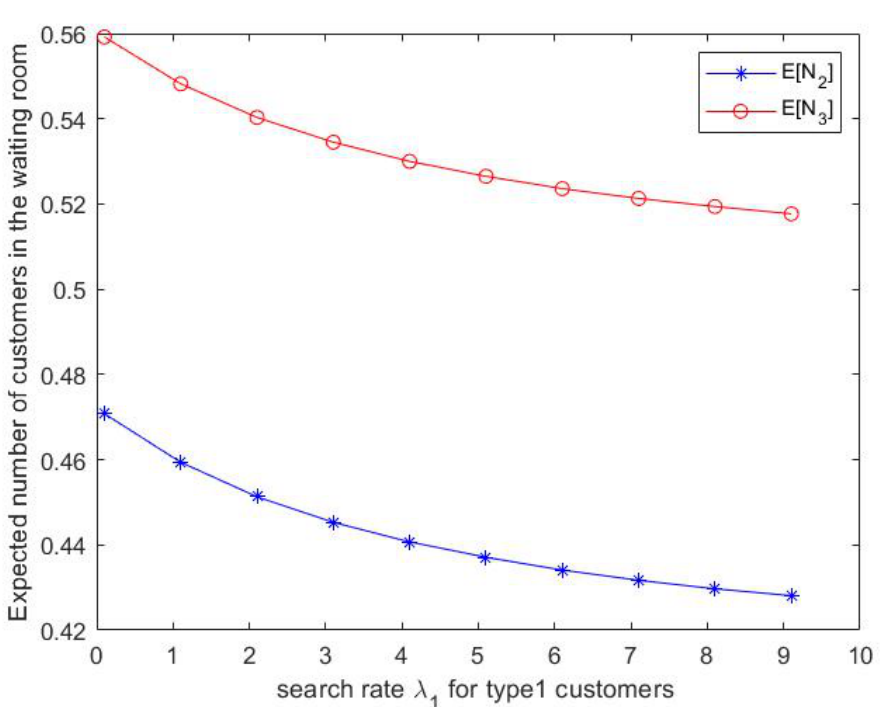
Figure 6. Effect of λ 1 on expected number of type 2,3 customers in waiting room 2,3.